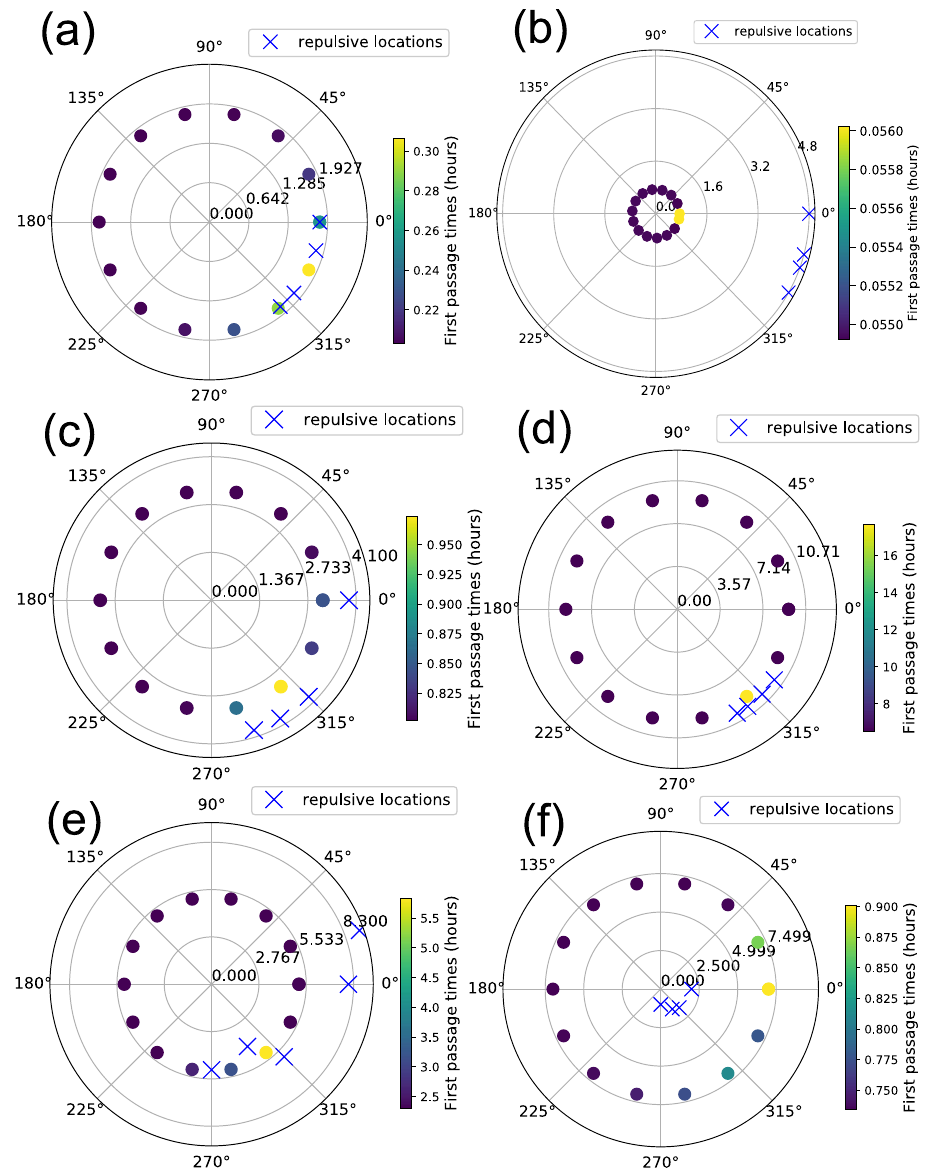
Figure 7. Polar plots depicting the locations considered for calculation of the first passage times. There is a one to one correspondence between the placement of the dots along respective directions in the plots in this figure and the corresponding plots in Fig. 6. The colour palette depicts first passage times in hours. The 0 degree direction represents east with respect to the actual landscape. Blue crosses show the location of repulsive features that are considered in computation of first-passage times. ( a ) GH1Br, ( b ) GH3Br, ( c ) GH4Br, ( d ) GH2NBr, ( e ) GH5NBr, ( f )